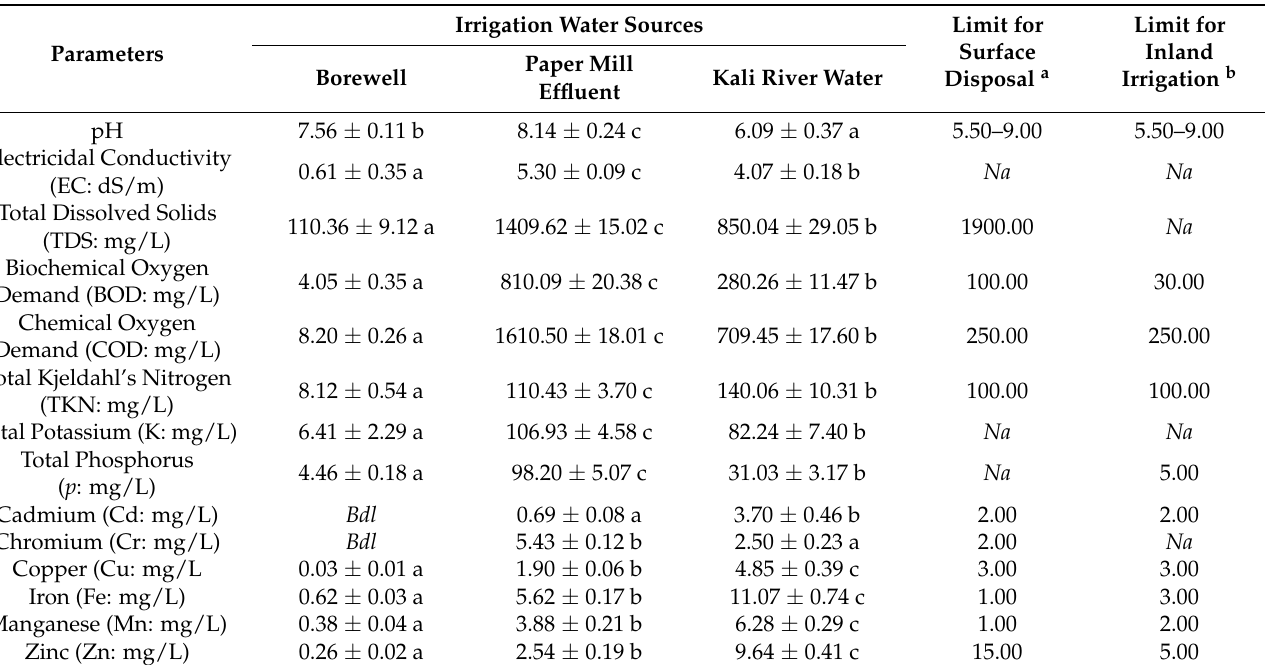
Table 1. Average characteristics of irrigation water sources (borewell, paper mill effluent, and Kali River water) of the study